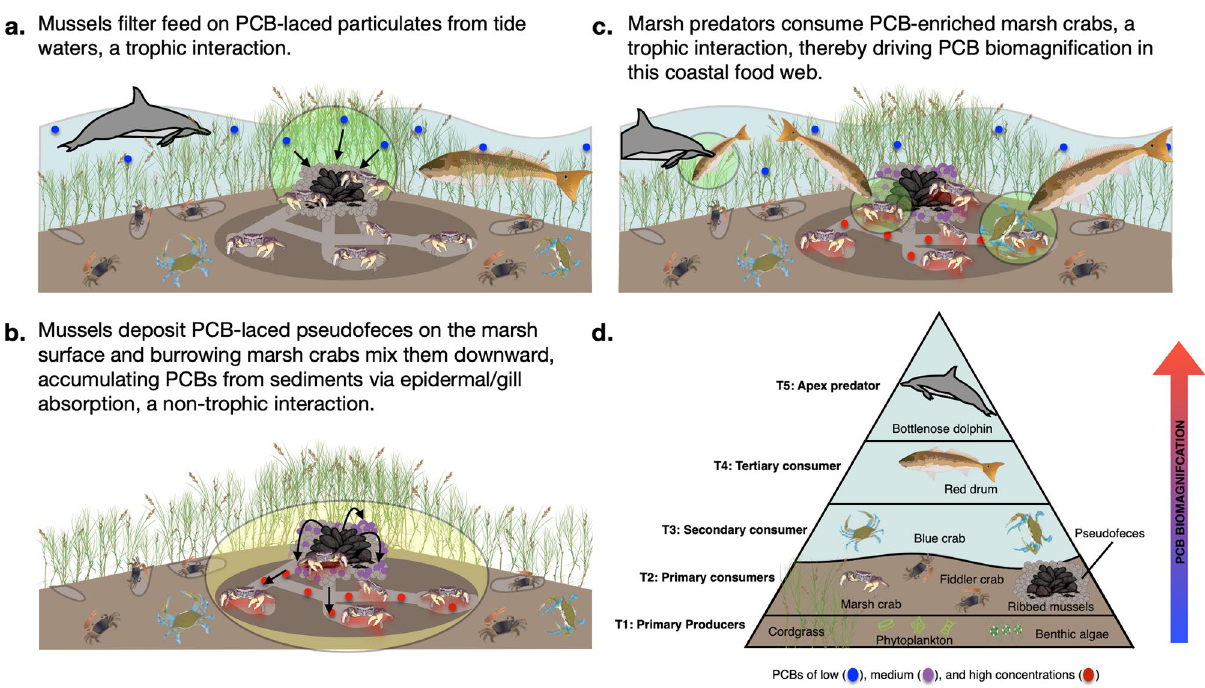
Figure 4. Trophic and non-trophic pathways of PCB biomagnification in saltmarsh food webs. Mussels enhance PCB concentrations in surface sediments through their filtration of PCB-laced particulates from the water column and deposition of pseudofeces ( a ). Marsh crab bioturbation, by aerating and mixing the pseudofeces into underlying marsh sediment, cause PCB concentrations to both increase and ‘sink’; and, through their sustained interaction with PCB-enriched sediment, the marsh crabs accumulate PCBs primarily through epidermal/gill absorption ( b ). Marsh crabs, as prey for nekton, then serve as vectors for PCB biomeagnification up the saltmarsh food web ( c ). Arrows signify the flow of PCBs, green and yellow circles identify trophic and non-trophic pathways, respectively, and blue, purple, and red circles denote relatively low, intermediate, and high PCB concentrations ( d ). Icons were obtainted through the Integration and Application Network or Google Imaged (labeled for reuse with reduced volume of organic sediment particles. Over time, this material gets pushed into deeper soil depths via crab burrowing. The pronounced difference in sediment PCB T between mussel and non-mussel enclosures supports our hypothesis that mussels rapidly elevate PCB concentrations via their filtration of PCB-enriched particulates from the tidewater and deposition of this material to the marsh surface (Fig. 4a,b). These findings, together with surveys showing that blue mussel ( Mytilus edulis ) biodeposits increase PCB sedimentation by 50% in the Baltic Sea 18 , highlight that suspension-feeding bivalves may generate ‘hotspots’ of PCB bioavailability in coastal sediments where tidal flow velocities are low enough to enable the settling of their PCB-enriched biodeposits. By summing concentrations of 65 congeners previously reported in the region 24 in our samples, we also found that sediment PCB concentrations in mussel enclosures (238 ± 35.7 ng/g dw) were nearly 3-times greater [and in non-mussel enclosures 5-times less (16.3 ng/g dw)] than the average total PCB concentration reported for the top 2-3 cm of archived saltmarsh sediment collected near the LCP facility in 1996, the year it was placed on the National Priorities List (79.3 ± 2.47 ng/g dw) 24 . Thus, mussels enhanced PCB concentrations in our enclosures to “superfund site-levels” within 5 months, highlighting the magnitude of their localized effects on enhancing PCB bioavailability. Mussel effects on crab PCB biomagnification. After 5-months on Blythe Island, fiddler crabs accu- mulated PCB T concentrations approximately 30-times greater (33.0 ± 6.8 and 28.4 ± 5.1 ng/g ww in no-mussel and mussel enclosures, respectively) than those collected directly from our reference site, Sapelo Island (PCB T :